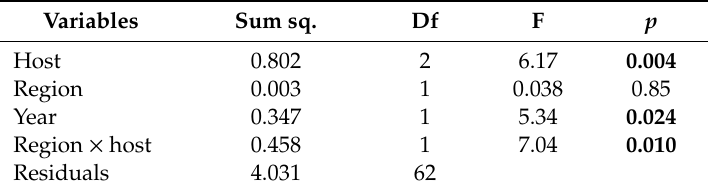
Table 2. Type II ANOVA table showing variation in phenological overlap between P. confusa and its hosts according to host species, region (south and north), year, and the two-way interaction between region and host species. R 2 adj = 0.25, p < 0.001. Significance above 0.05 indicated in